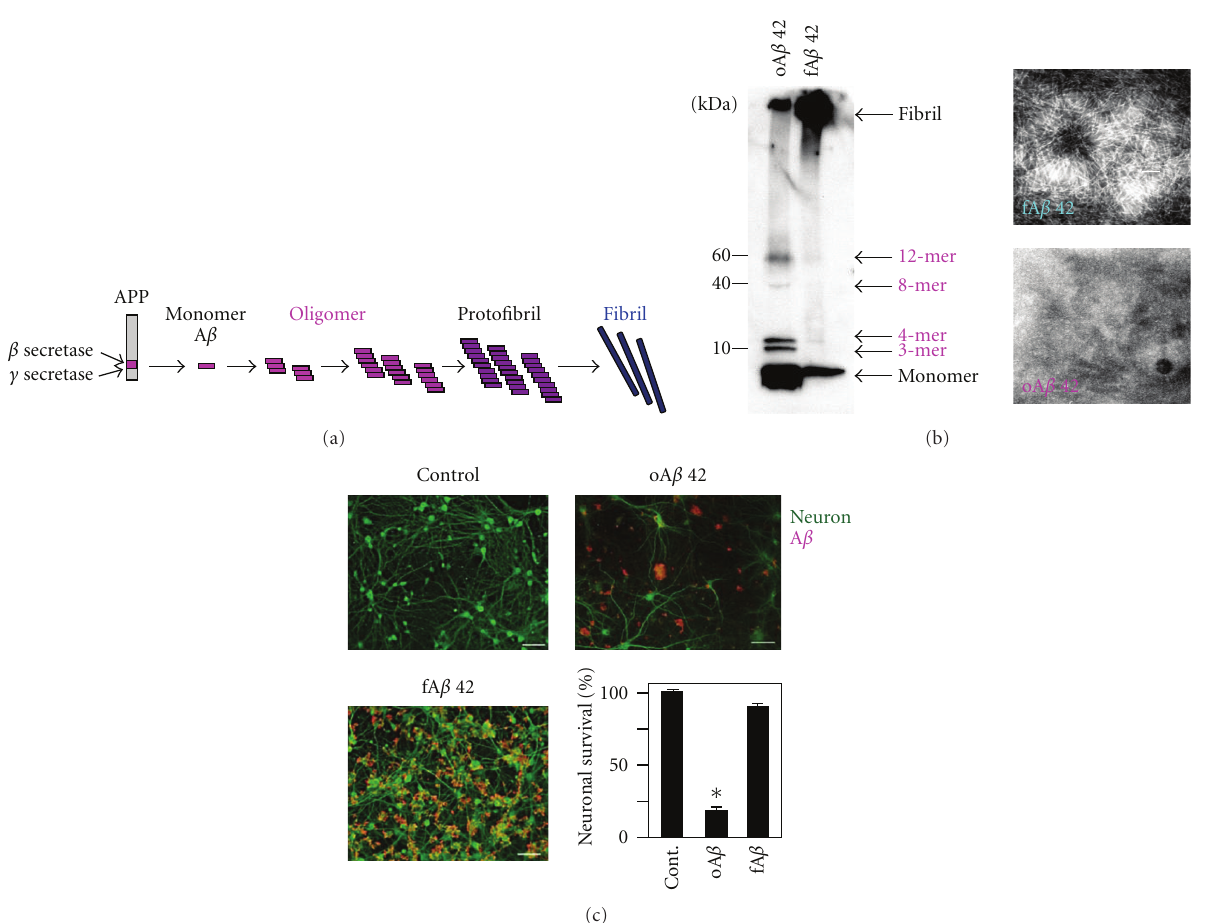
Figure 1: A β neurotoxicity. A β is derived from APP by enzymatic cleavage. A β consists of 40 or 42 amino acids. A β 40 is soluble and of lower toxicity, but A β 42 is prone to aggregate and form fibrillar structures via oligomers (a). Oligomeric A β (oA β 42) and fibrillar A β (fA β 42) are detected by western blotting and an electron microscope (b). Administration of 5 μ M oA β 42 to cortical cultures induces significant neuronal death. In contrast, administration of fA β 42 does not induce neuronal cell death, although A β deposition is observed on dendrites